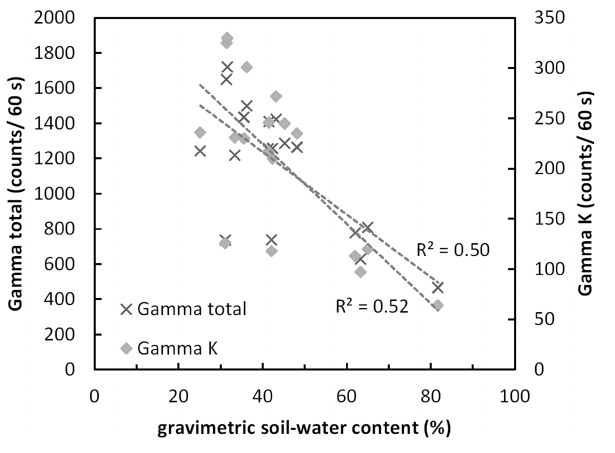
Fig. 5. Scatterplot of gravimetric soil-water content and total gamma counts (left axis) and radioaktive K (right axis).